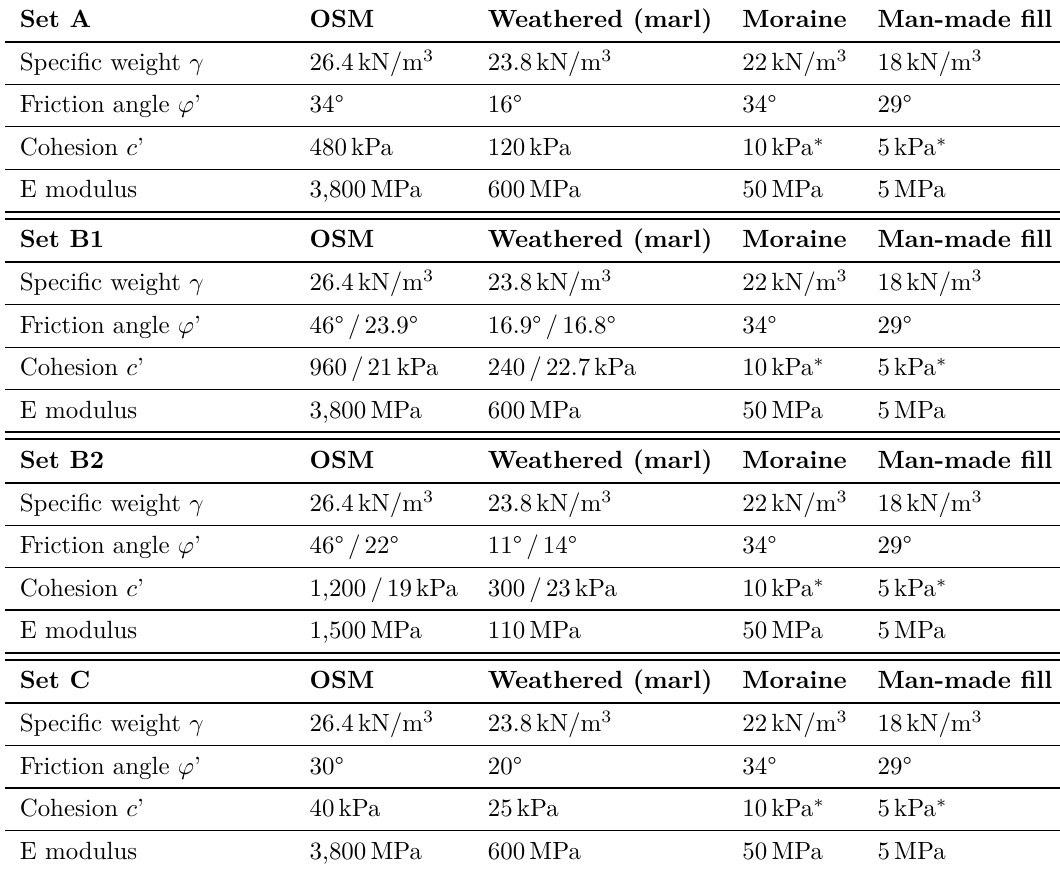
Table 2. Geotechnical